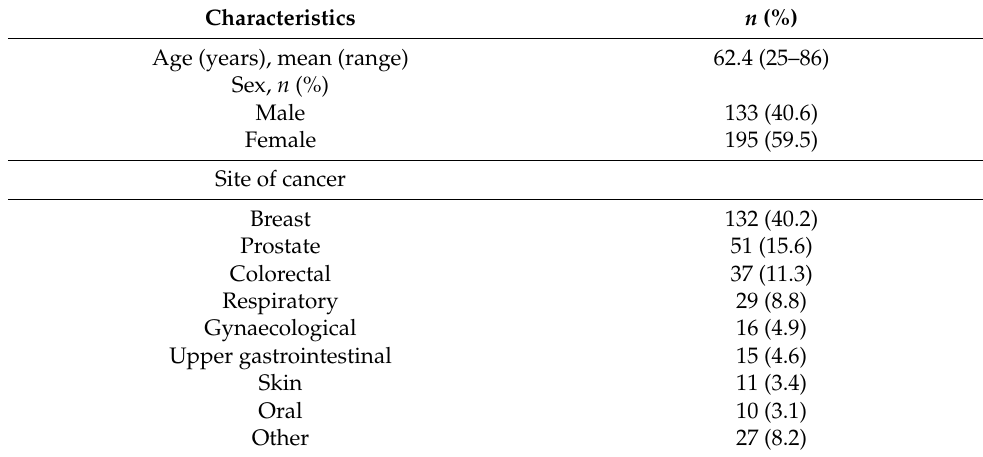
Table 1. Participant Demographic